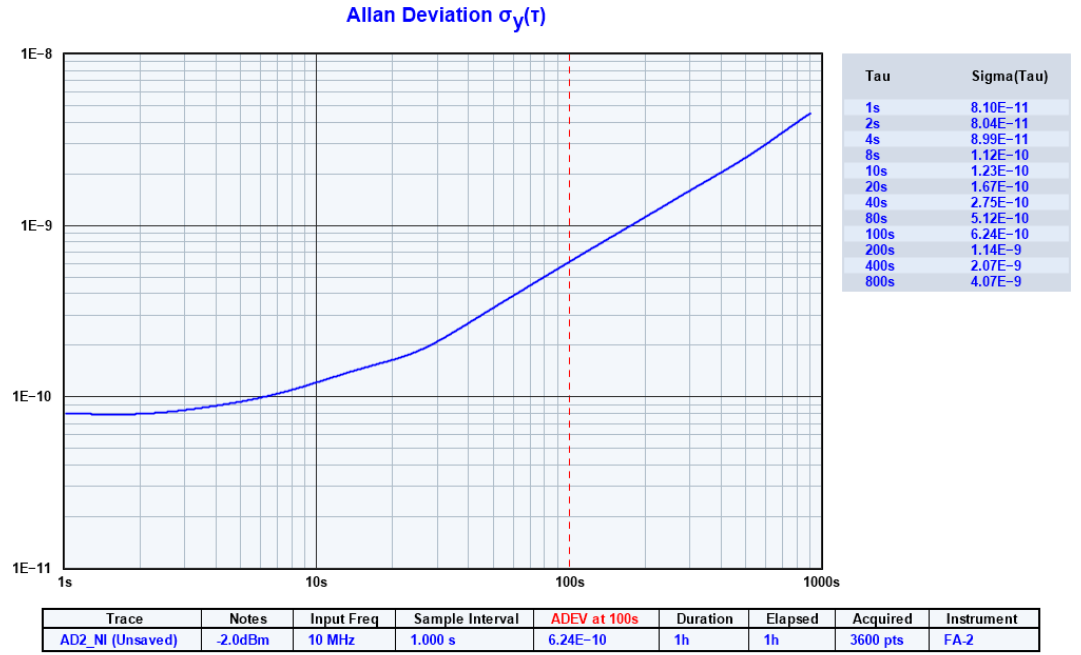
Figure 4. Allan deviation of the arbitrary wave generator (AWG) of the AD2.